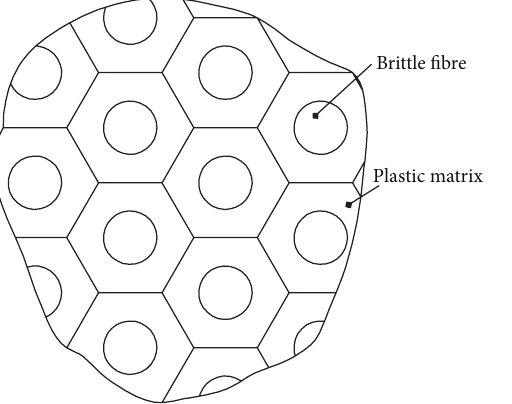
Figure 1: Typical cross section of the idealized composite.